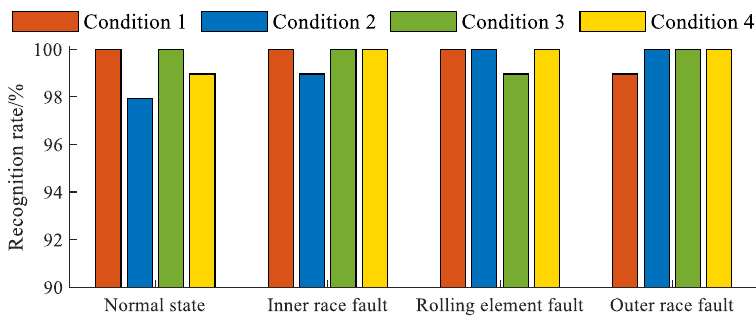
Figure 5. Diagnosis result of each in-wheel motor fault. Moreover, different numbers of observation samples were planned as training samples to demonstrate the robustness of the proposed diagnosis system. The above option of training samples was used to plan the other two. One option is that the observation samples are equally divided into training and test samples; another is to select 40% of the observation samples for training the diagnosis model and use the others for testing the ability. The above parameters of the in-wheel motor diagnosis system remain constant, and each diagnosis model is built to recognize the corresponding test samples for each condition. The classification accuracies of the four states of the in-wheel motor for each condition were over 95%. Here, the average accuracies of the three diagnosis models with different training options are shown in Figure 6. Although the training samples have significant differences, the fluctuations in the diagnosis accuracies are small. This indicates that the proposed diagnosis system for the in-wheel motor has good robustness.